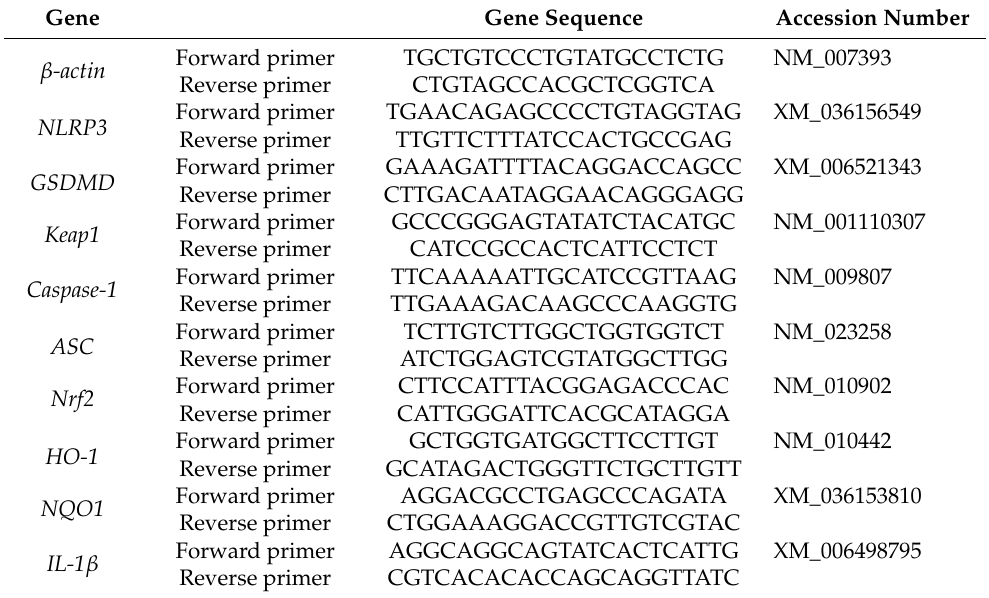
Table 1. Sequences of primers used for